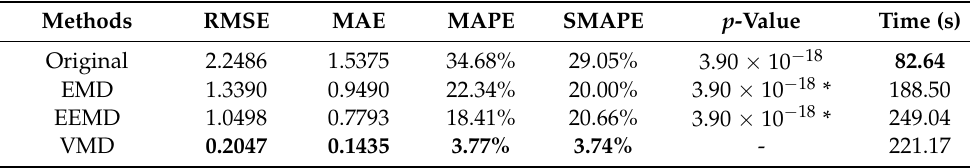
Table 5. Average accuracies of different decomposition methods.